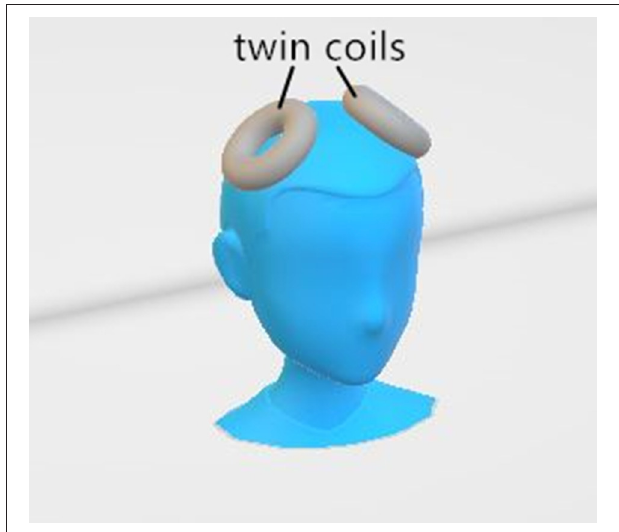
FIGURE 1 | The placement of the twin